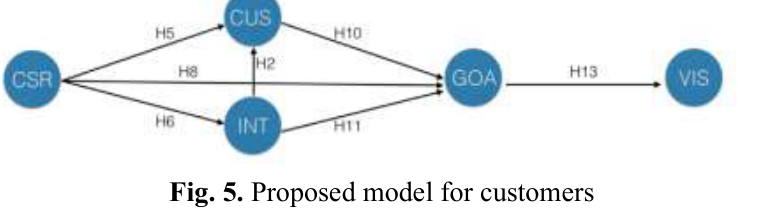
Fig. 5. Proposed model for customers